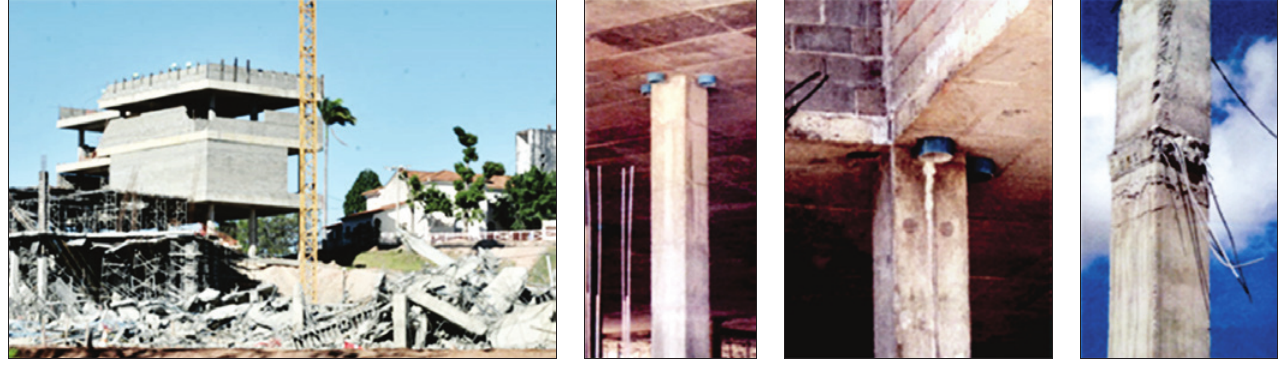
Visão geral da estrutura após o colapso